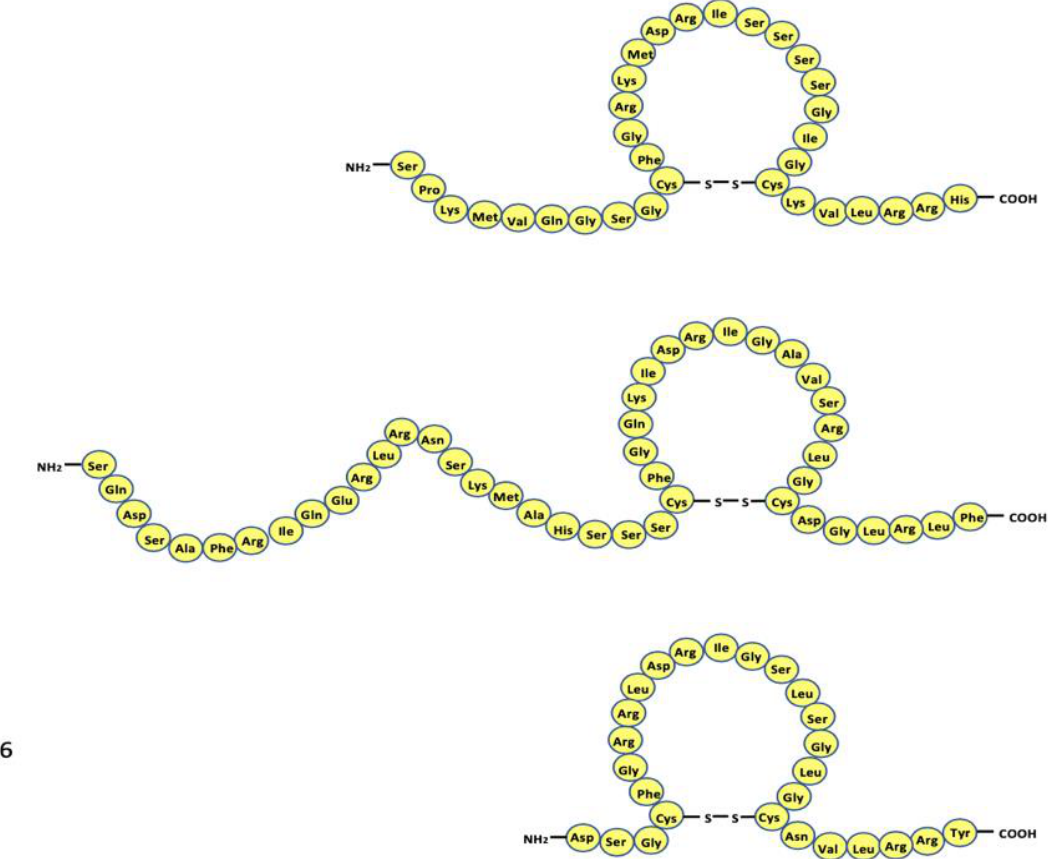
Figure 1. Amino acid sequence of circulating human, rat, and porcine B-type natriuretic peptide. Note that the amino acid sequence varies greatly among the species. The reason is described in the text.